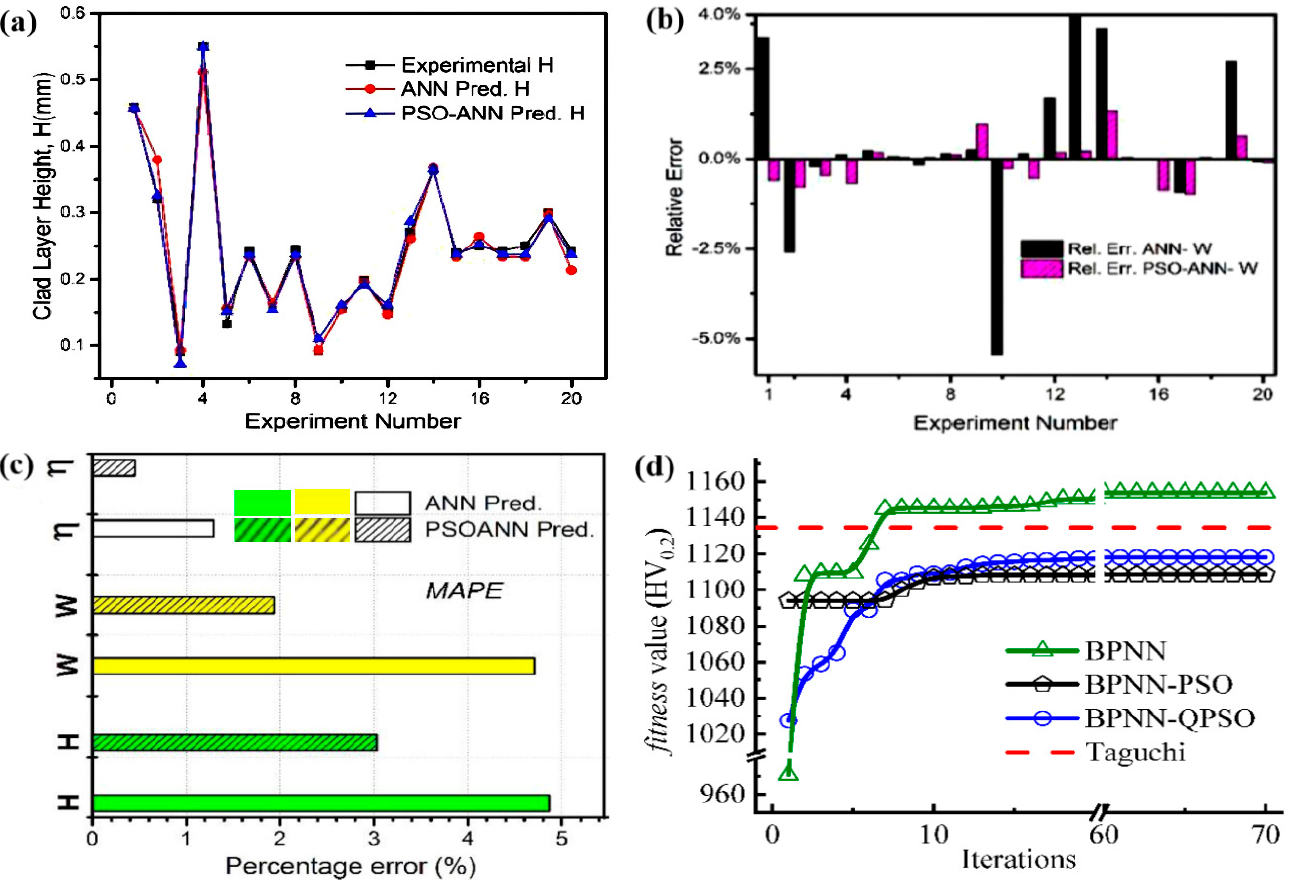
Figure 9. Performance comparison of a neural network model optimized by the particle swarm algorithm with a neural network model. ( a ) Comparison of experimental and ANN and PSO-ANN models’ predicted results for clad height. Reprinted with permission from Ref. [146]. 2020, Elsevier. ( b ) Relative error of ANN and PSO-ANN models for clad width. Reprinted with permission from Ref. [146]. 2020, Elsevier. ( c ) Performance comparison between the neural network and the PSO-ANN model. Reprinted with permission from Ref. [146]. 2020, Elsevier. ( d ) The iterative comparison of the coating microhardness fitness values under different optimization methods [147].